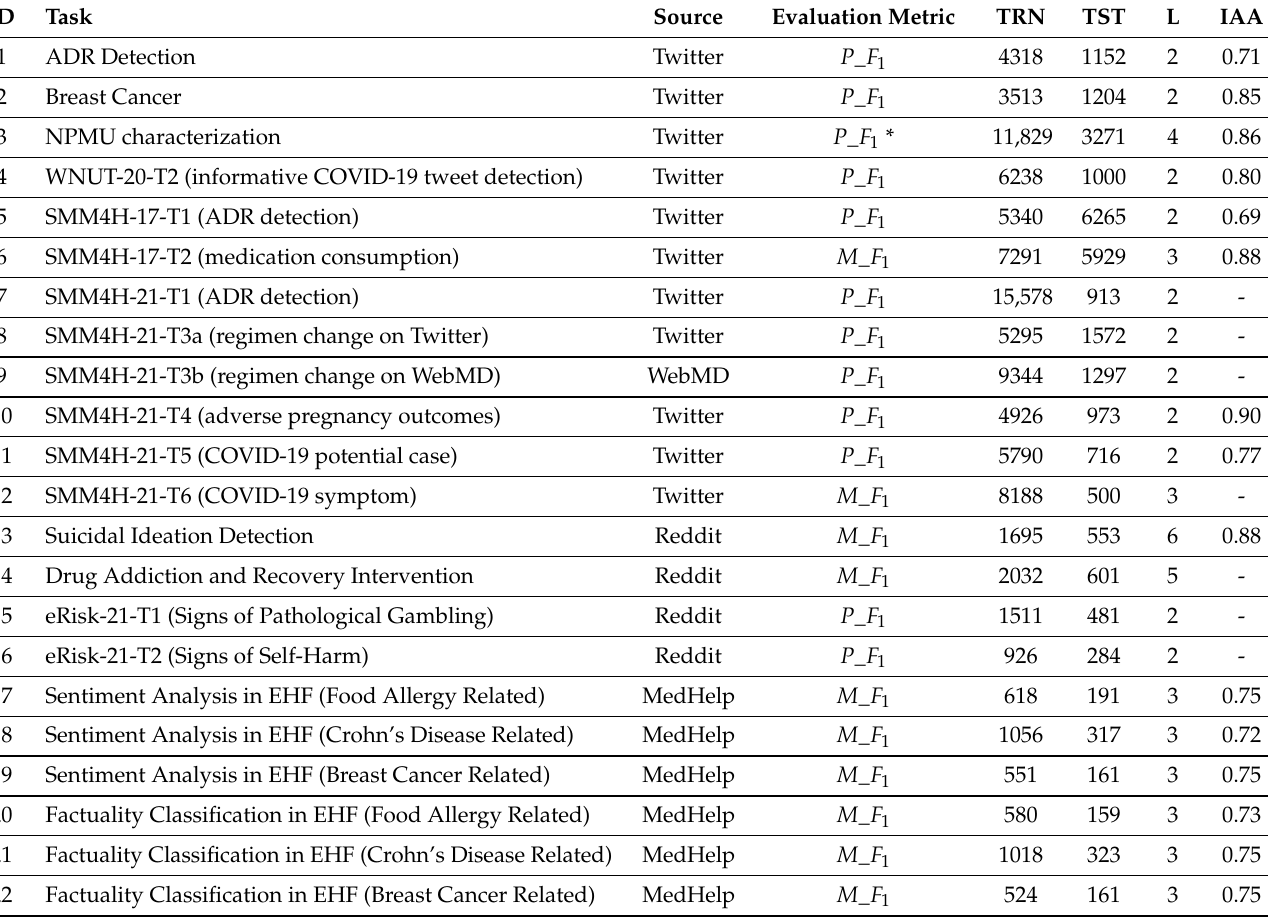
Table 1. Details of the classification Tasks and the data statistics. P _ F 1 denotes the F 1 -score for the positive class, and M _ F 1 denotes the micro-averaged F 1 -score among all the classes. * For NPMU, P _ F 1 denotes the F 1 -score of the non-medical use class. TRN, TST, and L denote the training set size, the test set size, and the number of classes, respectively. EHF denotes the e-health forum. IAA is the inter-annotator agreement, where Task 4 used Fleiss’ K, Task 13 used Krippendorff’s alpha, Task 17–22 provided IAA but did not mention the coefficient they used, and other Tasks used Cohen’s